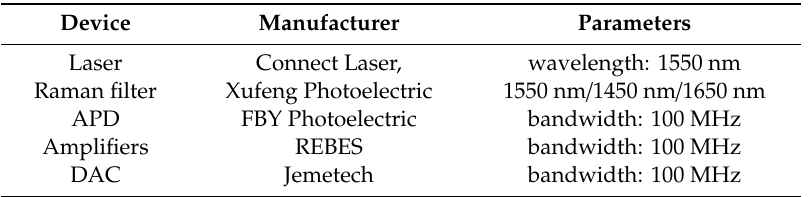
Figure 1. The experimental setup based on dual demodulation principle (DDP) scheme and Raman- based DTS prototype. APD: Avalanche Photodiode; WDM: Wavelength Division Multiplexing; MMF: Multimode Fiber; DAC: Data Acquisition Card. Table 1. Parameters of device in the experiment.